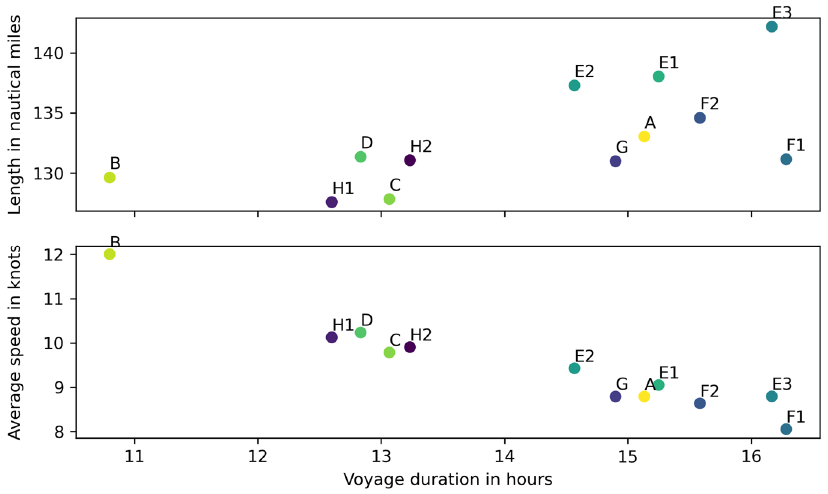
Figure 6. Scatterplot ( top ) of voyage duration (h) and average speed (kt) compared with voyage duration ( bottom ). The letters correspond to ship identification as stated in Table 1.